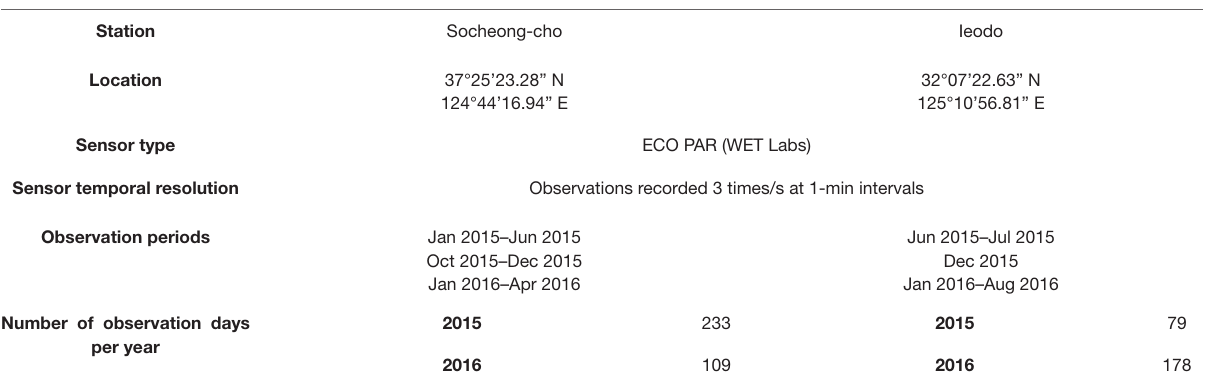
TABLE 1 Metadata for in situ daily PAR